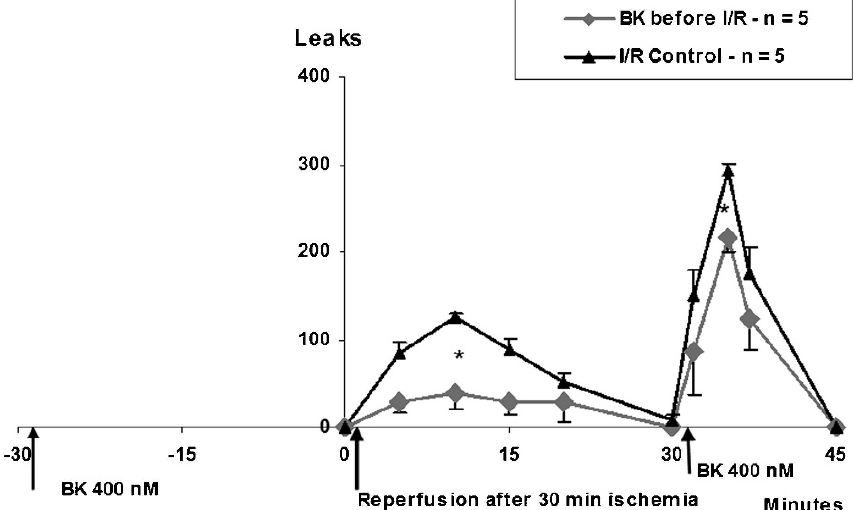
Figure 5 - Plasma leakage (maximal number of leaks ¡ SD) induced by ischemia/reperfusion (I/R) and 400 nM bradykinin (BK) without (Triangles) or with (Diamonds) bradykinin prior to I/R. Bradykinin prior to I/R reduced the subsequent response to I/R (from 125 to 40 leaks - 32% of control) and to bradykinin (from 305 to 225.7 leaks - 74% of control), * p